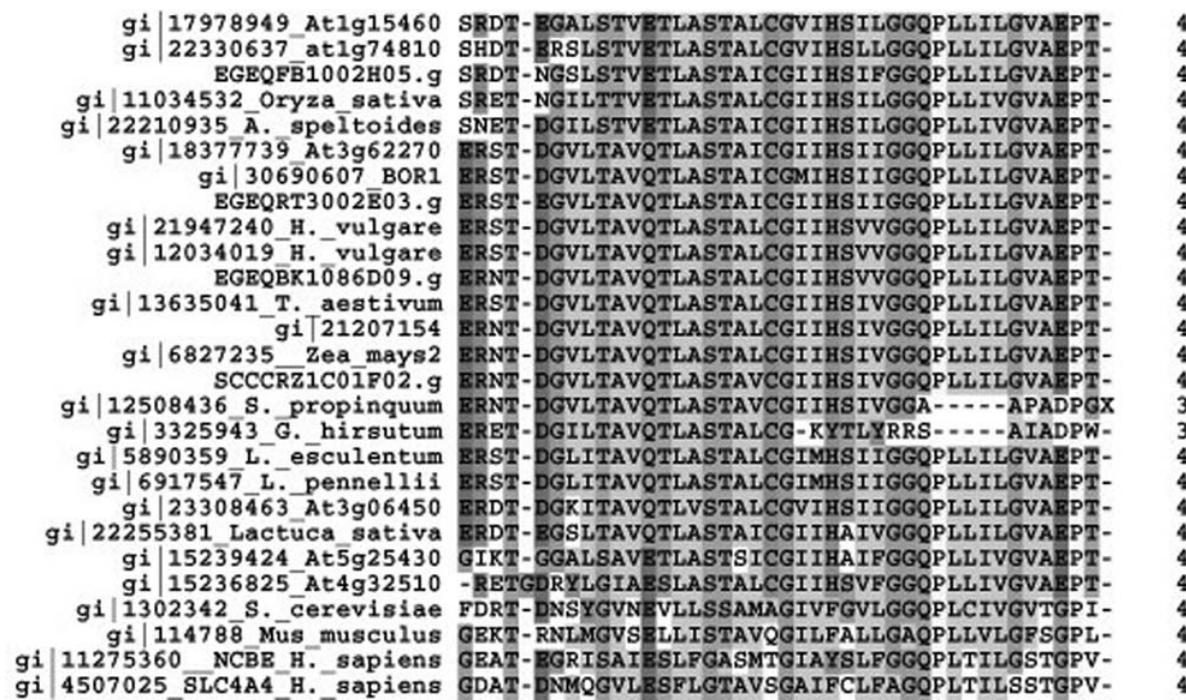
Figure1 -Multiplealignmentoftheconserveddomaininproteinsthatcontainedthesecondtransmembranedomainof BOR1 ,with10aminoacidsadded on each side of the common domain, was run in the Clustal X program. Genbank access (gi) of each sequence is indicated in each line. On the right is the analyzed region length.